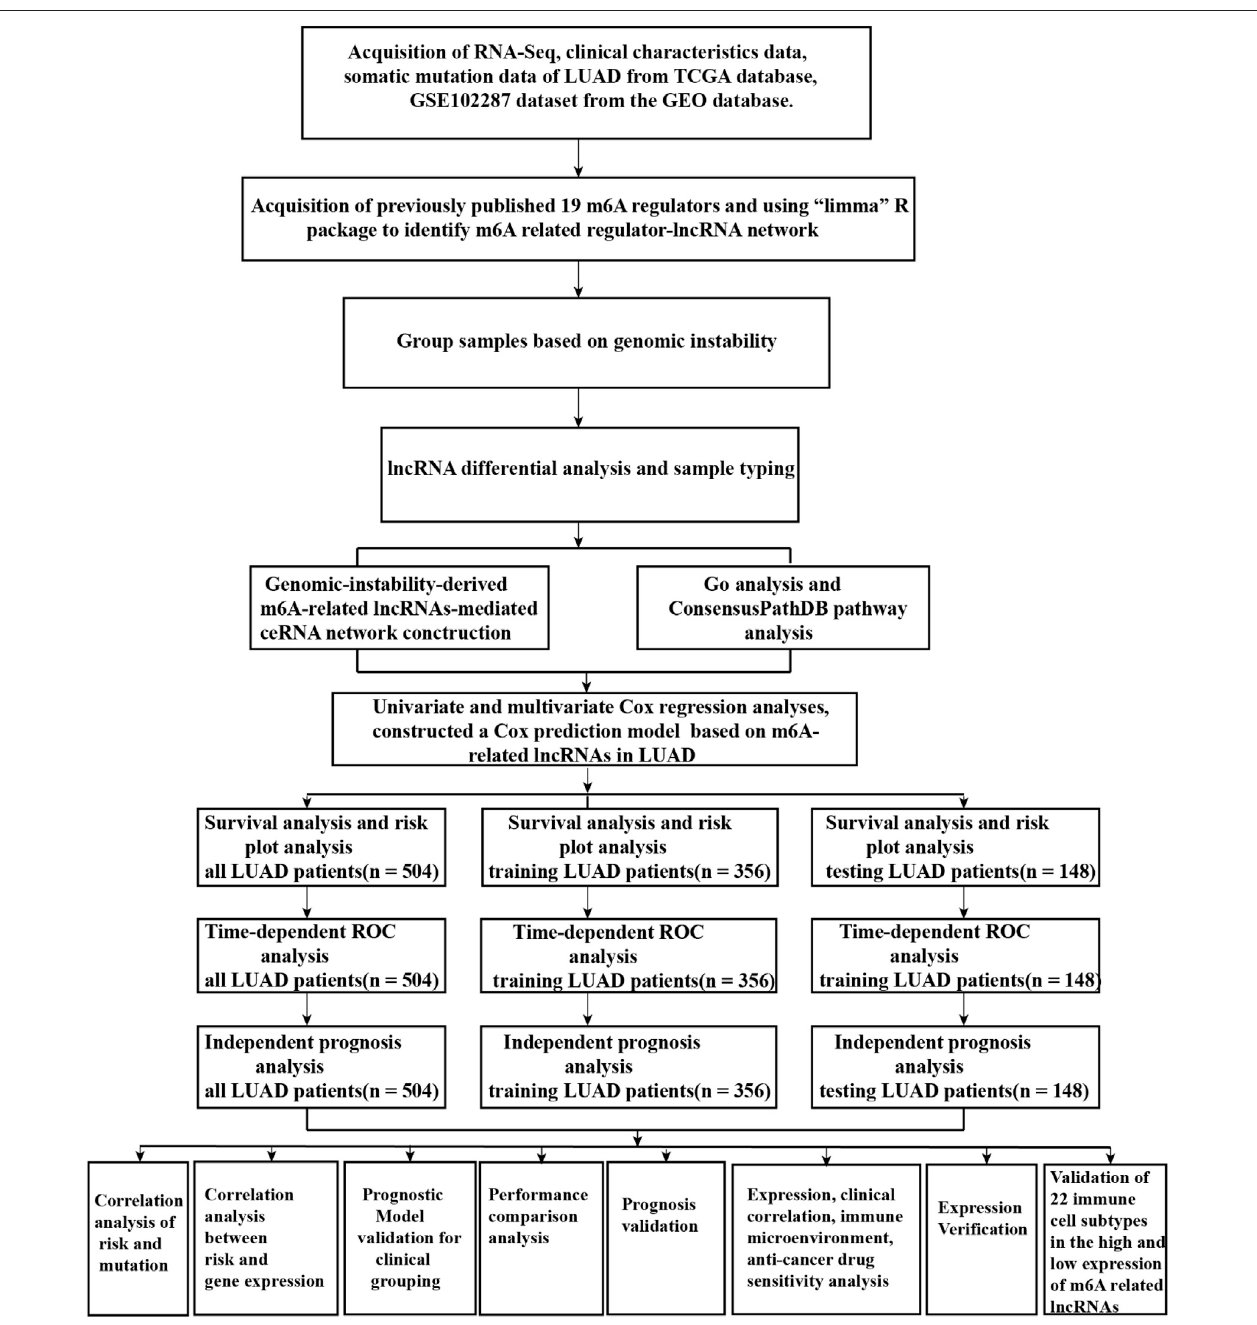
FIGURE 1 | Flow chart of the whole study.